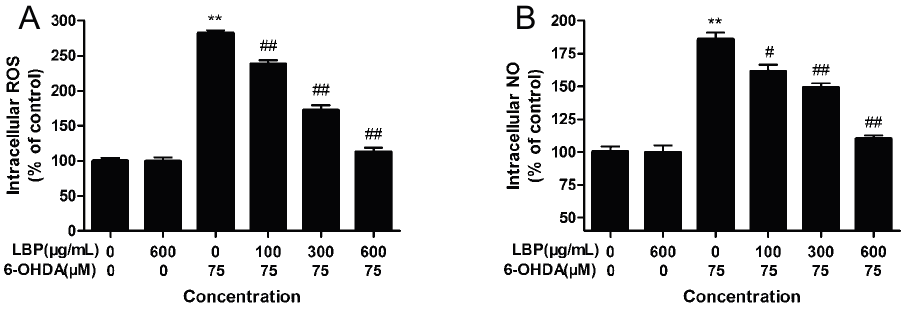
Figure 4. Effect of LBP on 6-OHDA-induced accumulation of intracellular ROS ( A ) and NO ( B ) levels. Cells were exposed to 6-OHDA without or with different concentrations of LBP for 24 h. Data are expressed as percentage of untreated control cells ± SD ( n = 6). ** p < 0.01 compared with untreated control cells; # p < 0.05, ## p < 0.01 compared with 6-OHDA-treated